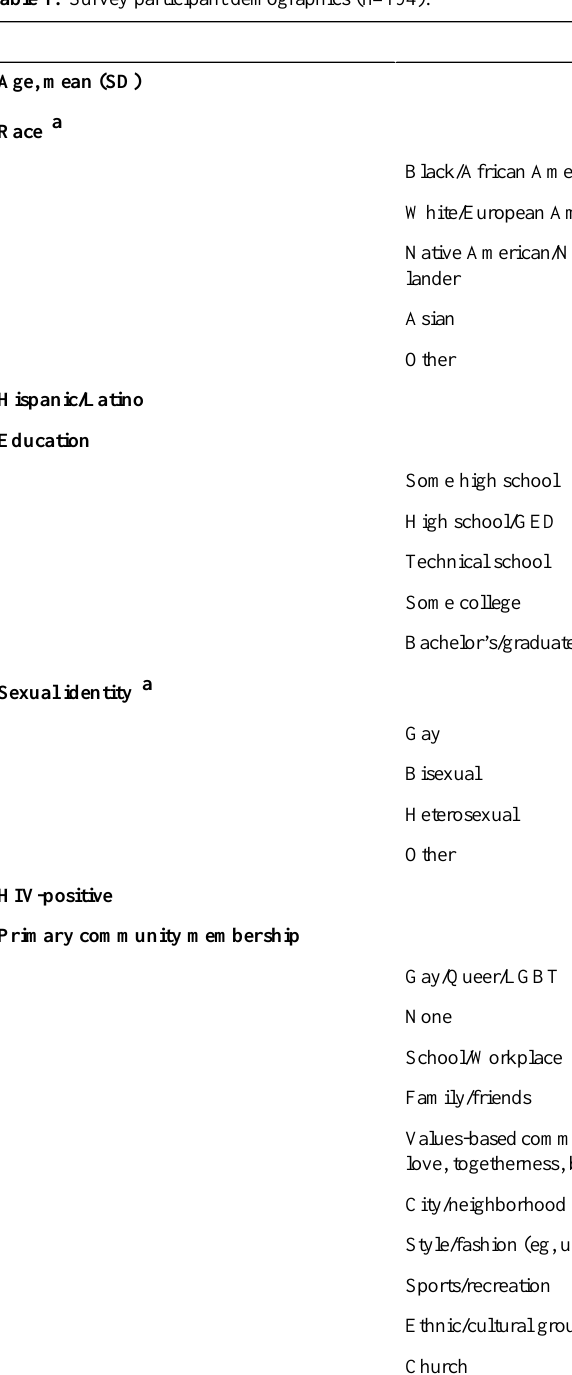
Table 1. Survey participant demographics